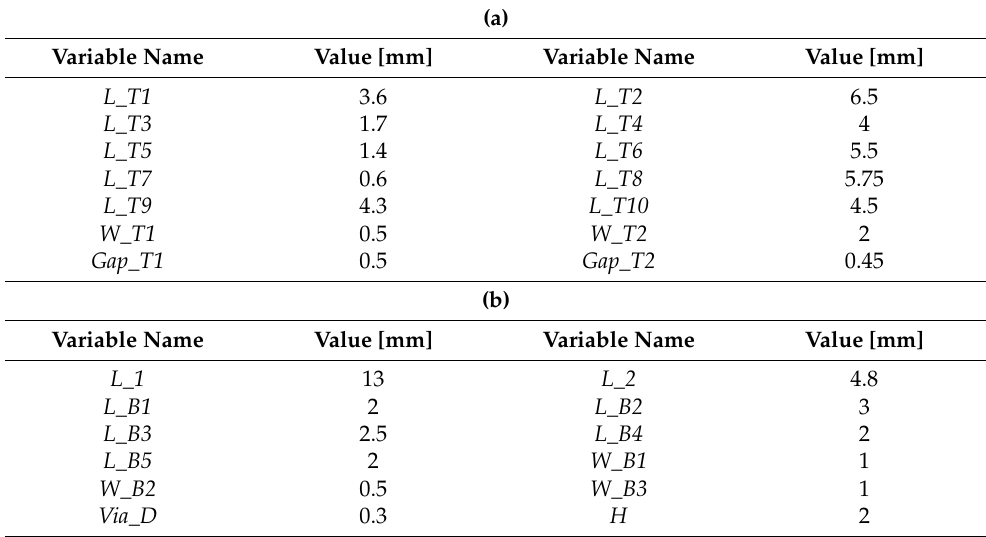
Table 2. The values of the geometrical parameters of the antenna. (a) Top surface; (b) bottom